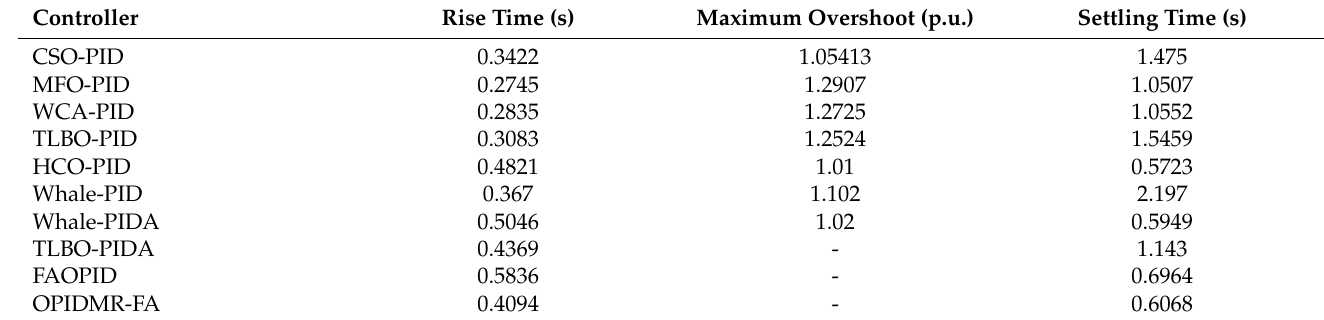
Table 3. Transient response parameters.